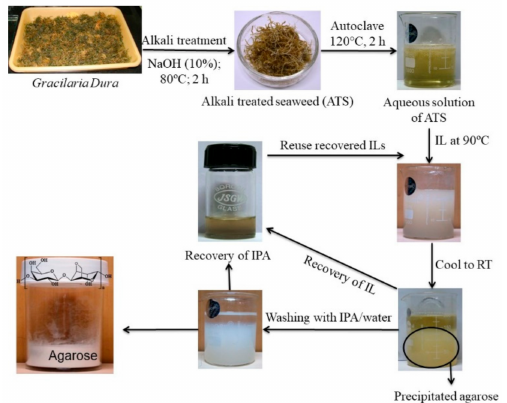
Figure 7. Selective precipitation of agarose using ionic